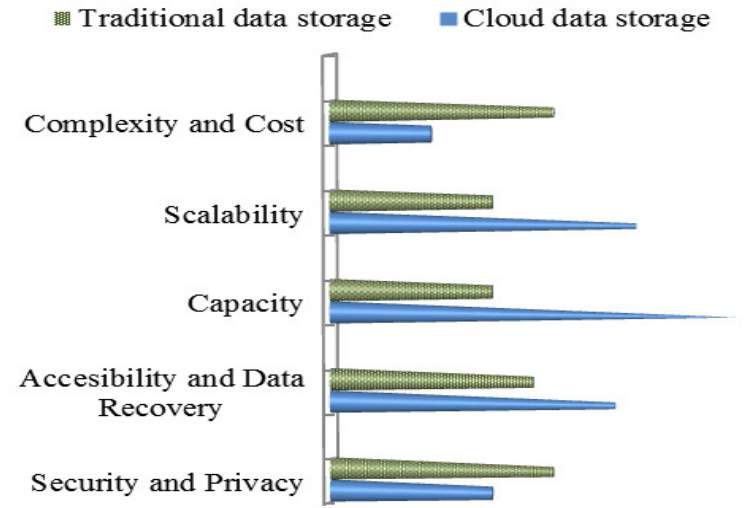
Figure 1. Traditional storage vs. cloud